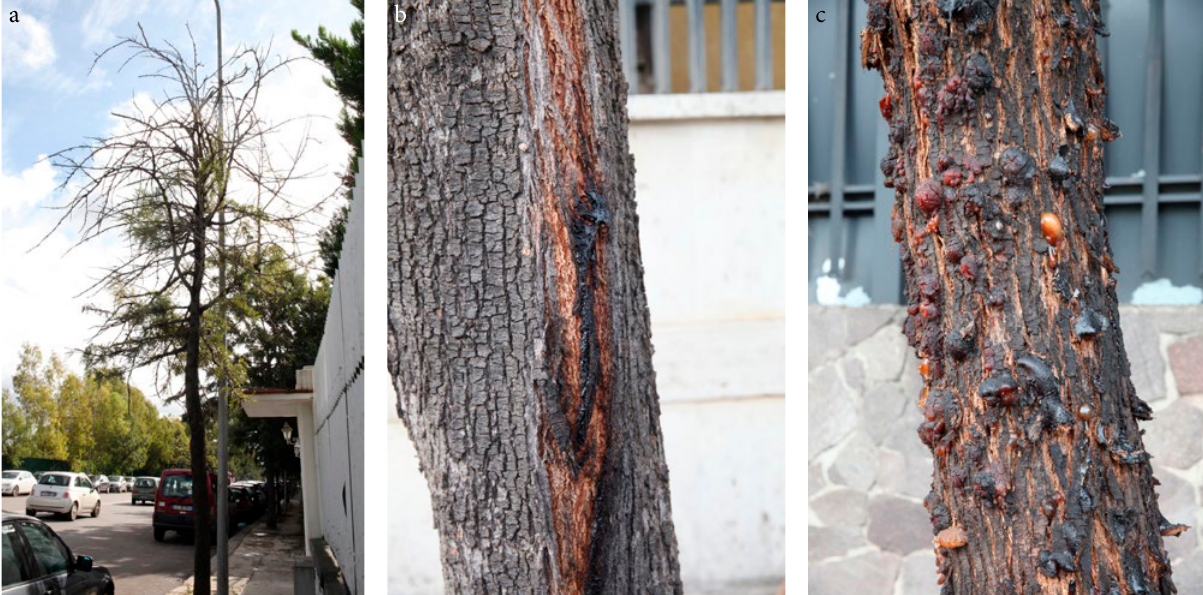
Figure 1. a, b: Symptoms of branch dieback and stem cankers, on Grevillea robusta . c: resin exudation on trunk.